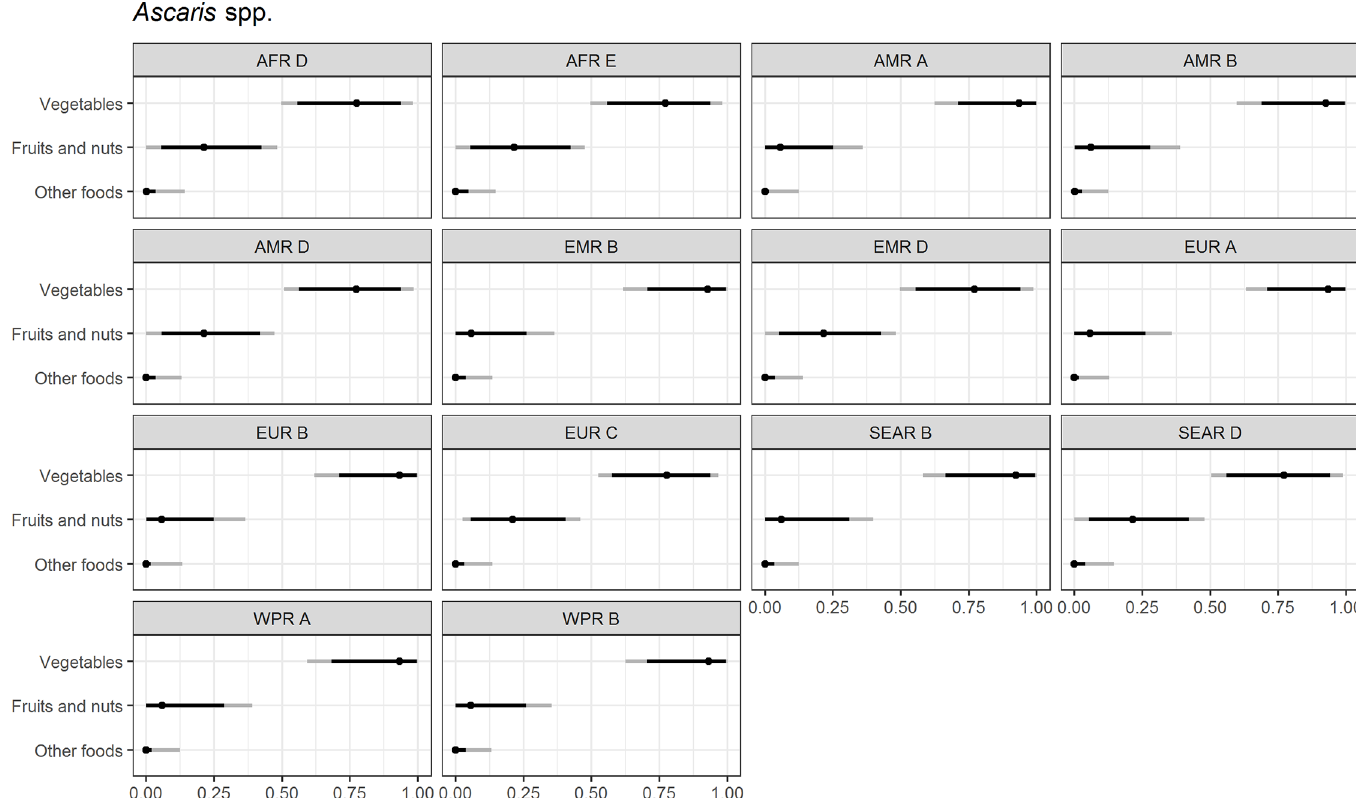
Fig 4. Ascaris spp. Proportion of foodborne disease attributable to specific foods: Median estimate, and 90% and 95% uncertainty intervals by parasite and subregion. “Small ruminants’ meat” was listed as “Goat, lamb and other small ruminants’ meat” in the expert elicitationinstrument. The X-axis labels are percentages. The dot representsthe median estimate; the dark black line, the 90% uncertainty interval; and the gray line the 95% uncertainty interval.